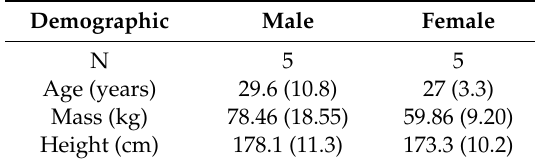
Table 1. Mean (standard deviation) for participant age, mass, and height.